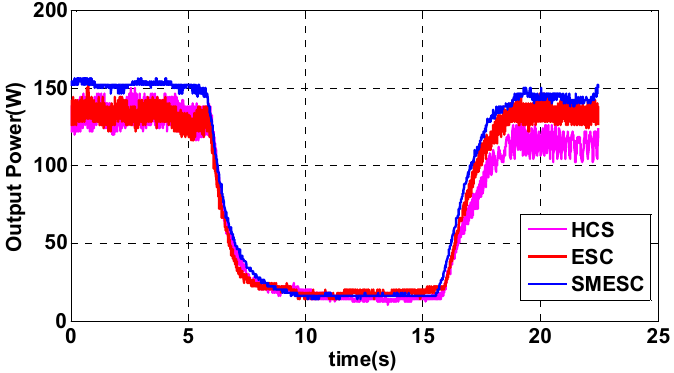
Figure 19. Comparison map of HCS, ESC, SMESC: Wind speed is dropped from high to low and then raised to high